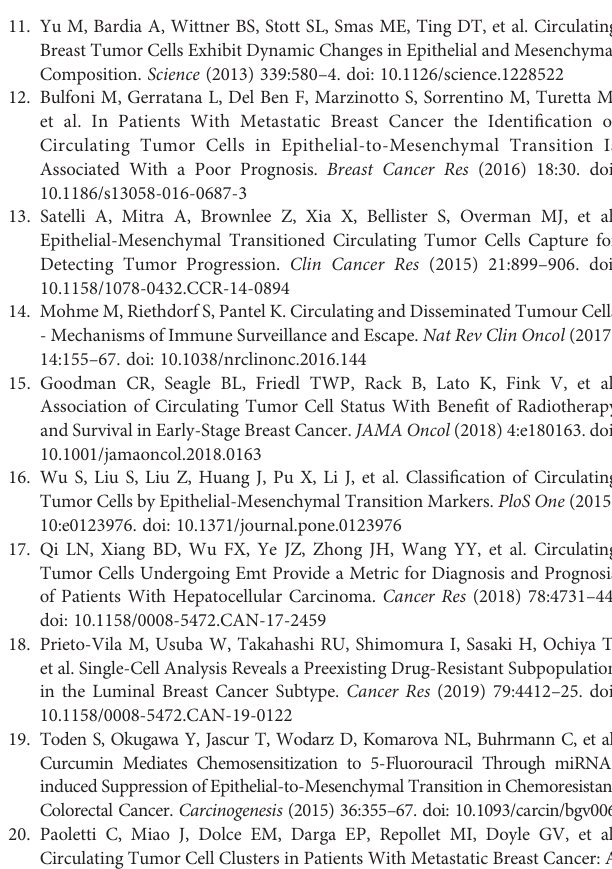
Supplementary Table 1 | Multivariate analysis of clinicopathological characteristics and the detection of CTCs and EMT-like CTC-WBC clusters for predicting the progression-free survival in HR-positive/HER2-negative metastatic breast cancer